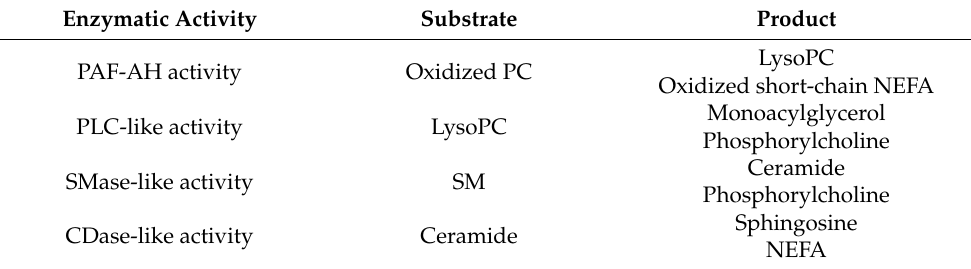
Table 3. Substrates and products of enzymatic activities in LDL( −